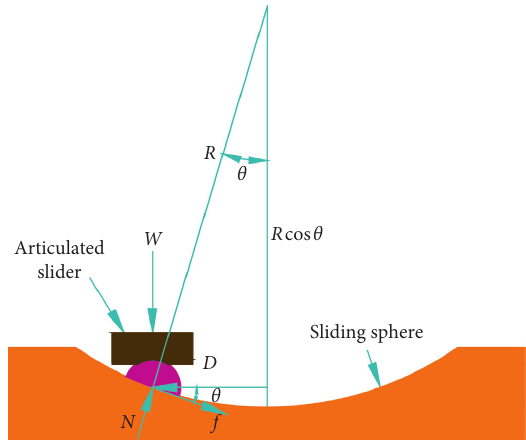
Figure 4: Schematic diagram of the simple pendulum model.